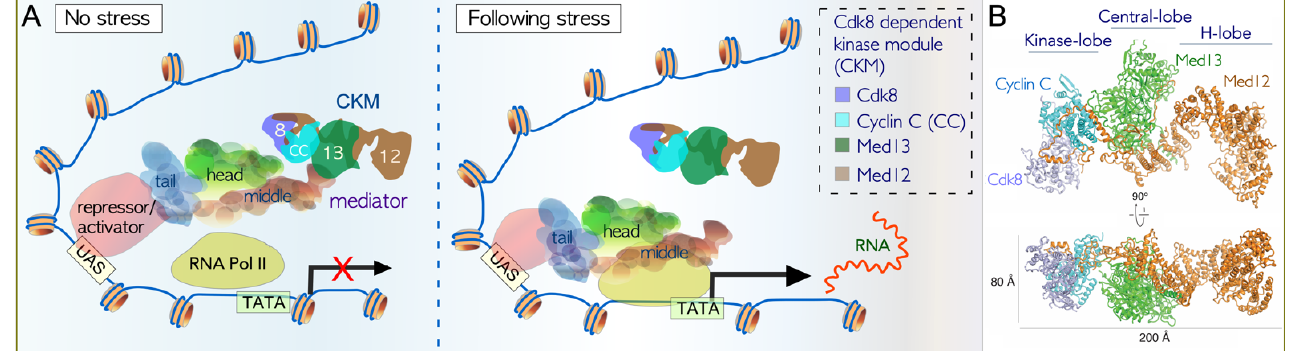
Figure 2. Model of the interaction of the CKM with the core mediator complex and RNA Pol II. ( A ). In unstressed cells, the CKM associates with the Mediator at UAS sites found in promotors, by the interaction of Med13 with the mediator hook. This inhibits the Mediator-RNA pol II interaction, preventing PIC formation and transcription of mRNA. Following stress, the CKM is released from the Mediator, permitting PIC assembly and transcription of mRNA. Additional repressors and/or activators also mediate transcription by binding to UAS motifs (Upstream Activating Sequence). Adapted from Cherji et al (2017). NAC. PMID:28575439. ( B ) Structure of the yeast CKM determined by cryo-EM and mass spectrometry. Reproduced with permission from Li et al (2021) Scientific Advances. PMID: 33390853. CKM—Cdk8 kinase module,